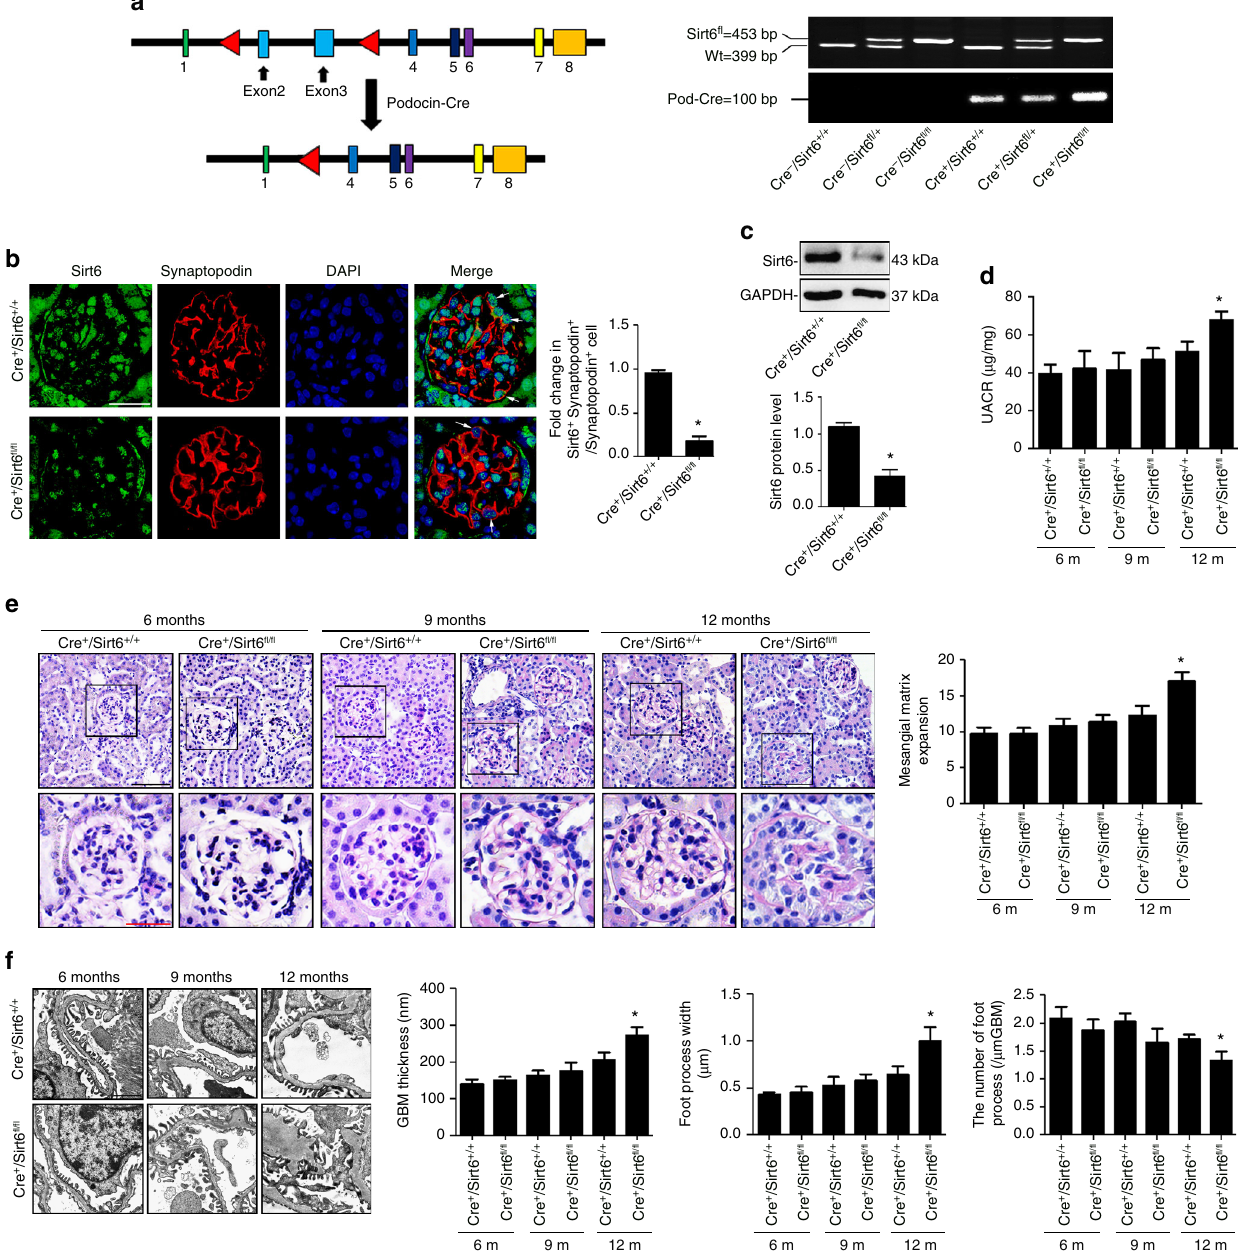
Fig. 3 Establishment of podocyte-speci fi c Sirt6 knockout ( Cre + /Sirt6 fl / fl ) mice. a Generation of conditional knockout mice in which Sirt6 is speci fi cally ablated in podocytes by using Cre – LoxP recombination system. Exon 2 and 3 are deleted upon NPHS2-Cre -mediated recombination. Genotyping was con fi rmed by tail preparation and PCR at 2 weeks of age. b Podocyte-speci fi c loss of Sirt6 was con fi rmed by immuno fl uorescent staining of Sirt6 in podocytes, synaptopodin was used as a podocyte marker. The arrows indicate representative podocytes. Scale bar , 25 μ m. c Representative western blot gel documents and summarized data showing the decreased expression of Sirt6 in isolated glomeruli from podocyte-speci fi c Sirt6 knockout (Cre + /Sirt6 fl / fl ) mice. d UACR (urine albumin-to-creatinine ratio) in mice at different age. e Photomicrographs and quanti fi cations showing typical glomerular structures in mice at different age. Scale bar : black 50 μ m, red 25 μ m. f Representative photomicrographs and quanti fi cations of mean glomerular basement membrane (GBM) thickness, mean foot process width, and the number of foot processes in different groups of mice at different age by transmission electron microscopy (TEM) analyses. Scale bar , 2 μ m. Podocyte-speci fi c Sirt6 knockout mice: Cre + /Sirt6 fl / fl mice; Mice with two WT alleles and Cre expression ( Cre + /Sirt6 + / + ) were used as controls. * P < 0.05 vs. control ( Cre + /Sirt6 + / + mice). ( n = 8.) Data are expressed as means ± SE. Student ’ s t -test was employed for comparisons between two groups; one-way ANOVA followed by Tukey ’ s post-test for multiple comparisons was used for groups of three or